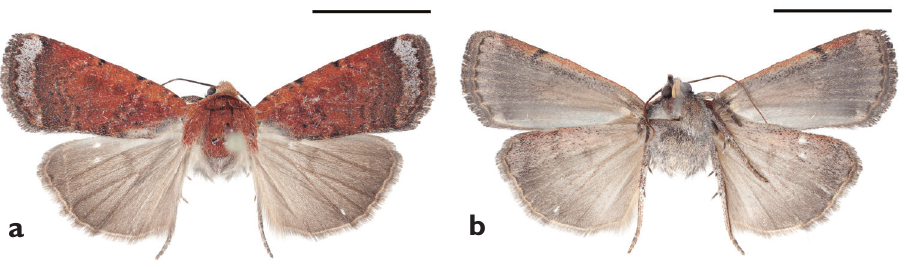
Figure 14. Holotype of Abagrotis crumbi Franclemont (= nefascia ). a Dorsal b Ventral Scale bars: 1 cm (Photos B.